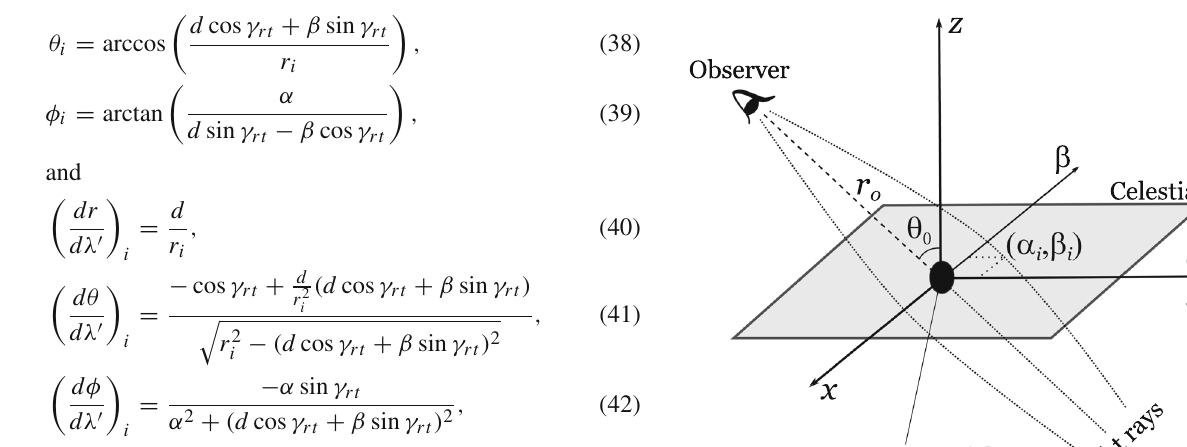
from the center of the image D , the average radius of the sphere (cid:9) R (cid:10) , and the asymmetry parameter A . Since the KRZ spacetime is axially symmetric, the parameter D is always identically equal to zero. In the papers Refs. [111,112] authors proposed different ways to describe the shape of the shadow. However, the results of the different approaches are similar to each other. The average radius (cid:9) R (cid:10) is the average distance of the boundary of the shadow from its center, which is defined